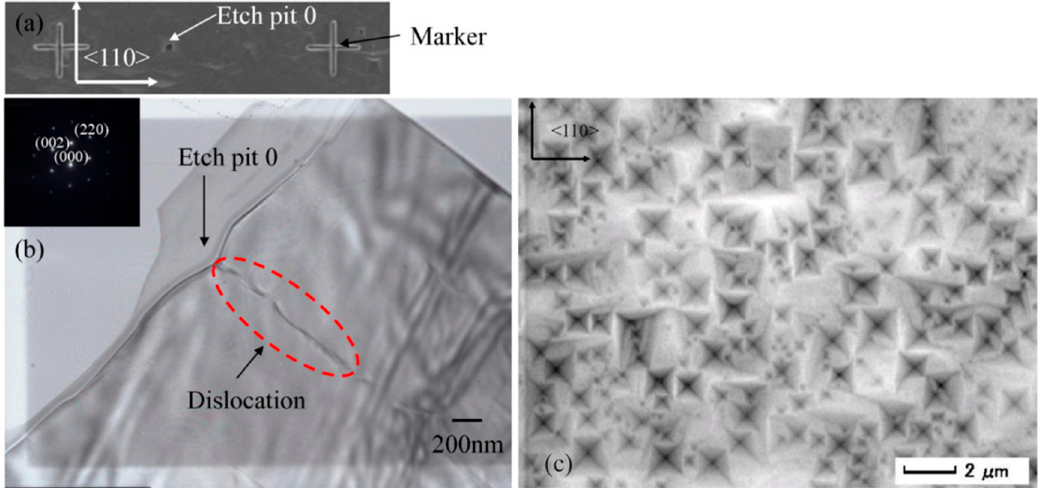
Figure 3. ( a ) Scanning ion microscopy (SIM) image of an etch pit and marker fabricated along the bottom located at the center of the etch pit for TEM sample preparation. ( b ) Cross-sectional TEM image (bright field) of an etch pit taken along the <110> zone axis. The inset is the TED pattern used for imaging. ( c ) Plan-view SEM image of etch pits formed at 900 °C for 6 h by hydrogen plasma [54]. Reproduced with permission from Elsevier.